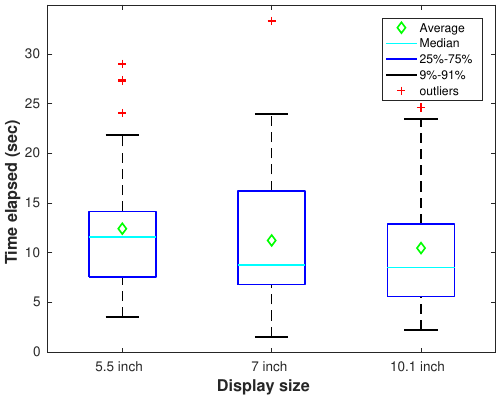
Figure 1. Some frames of the prototype application viewed by volunteers during the experiment. (a) scene without the virtual object, (b) application start screen, (c) soccer ball, (d) basketball and (e) final application screen.